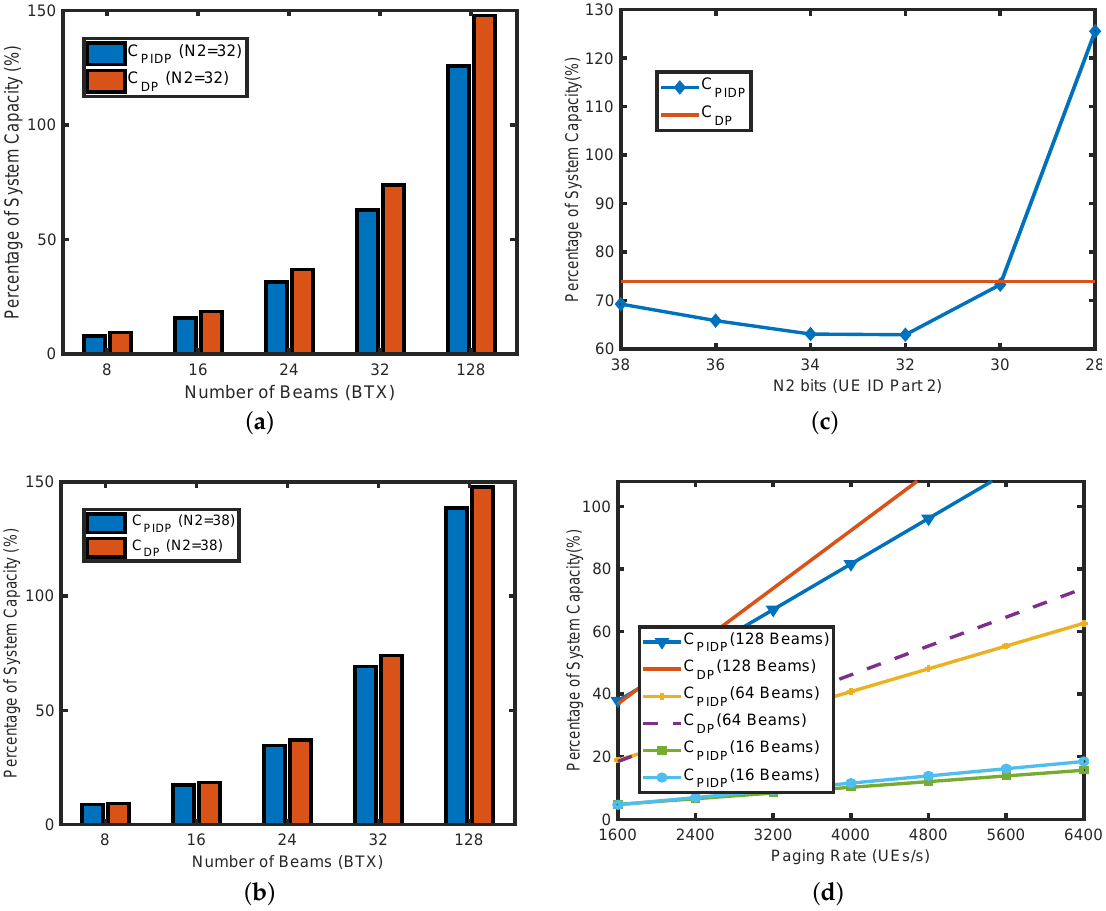
Figure 5. ( a ) Percentage capacity vs. the number of beams (32 bits); ( b ) percentage capacity vs. the number of beams (38 bits); ( c ) Percentage capacity vs. the cropped UE ID size; ( d ) Percentage capacity vs. the paging